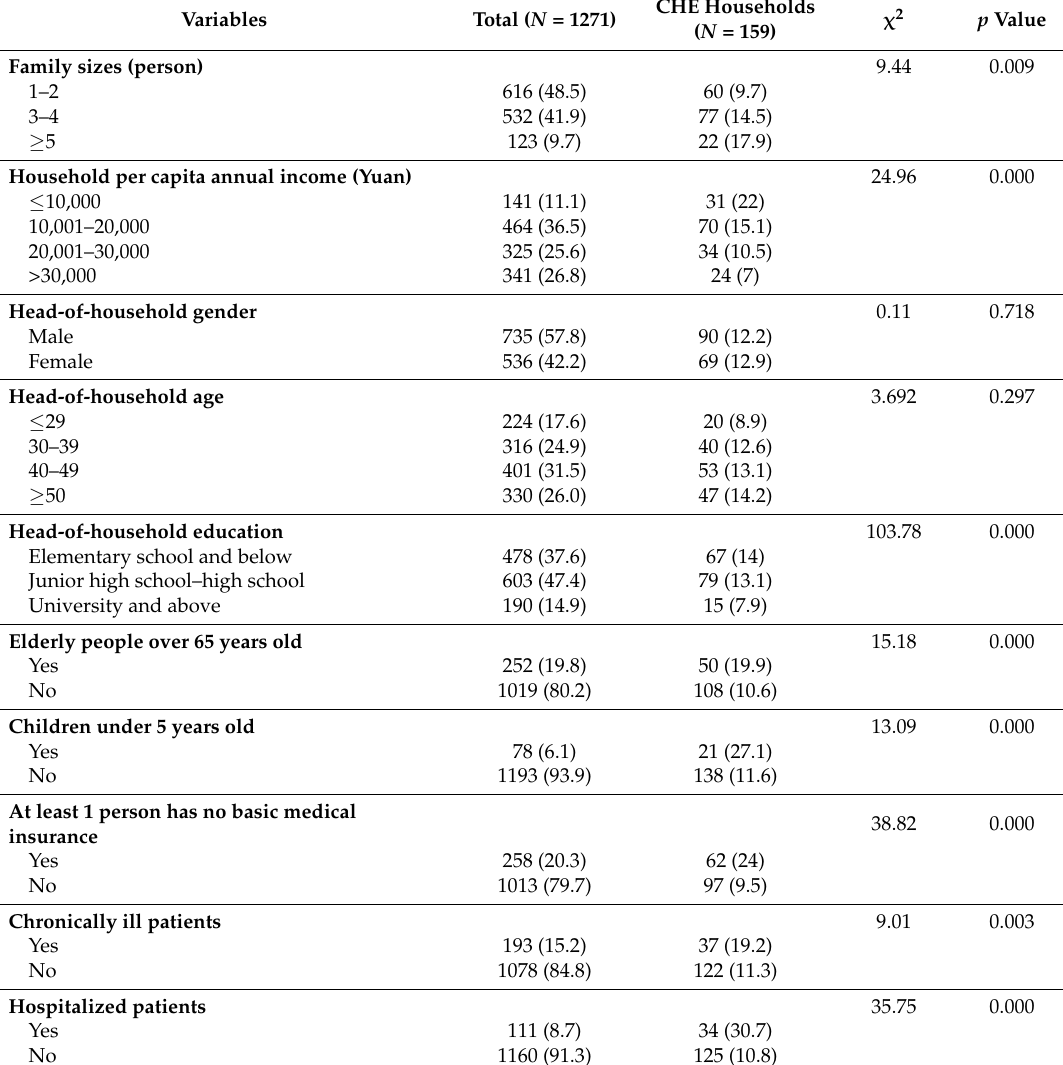
Table 1. Univariable analysis of different migrant workers’ family characteristics (N, %). Variables Total ( N =